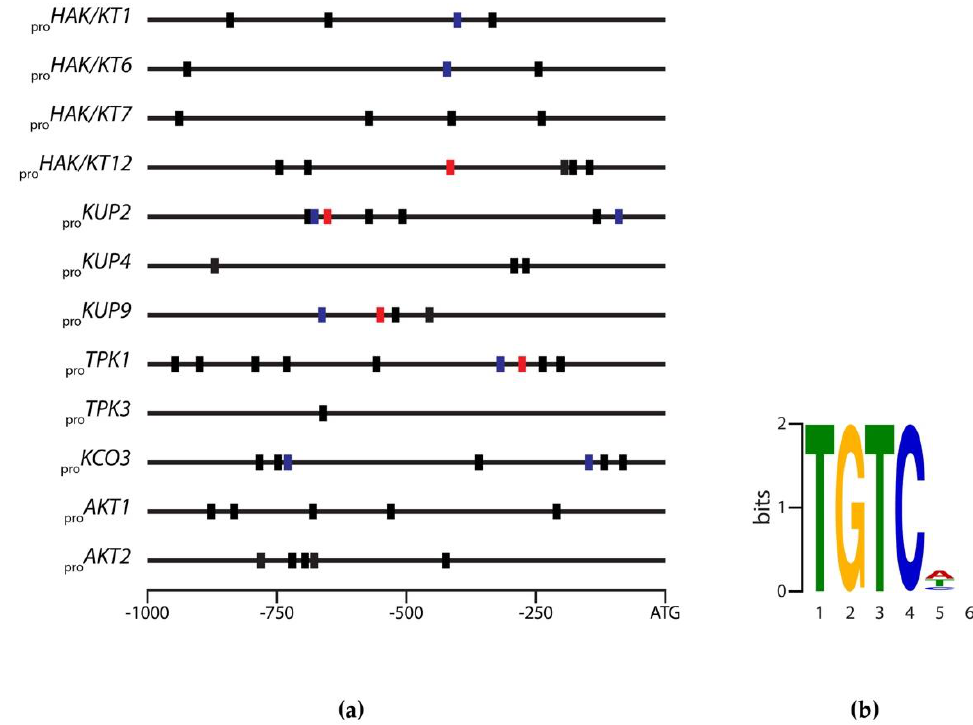
Figure 3. Identification of conserved auxin response factor (ARF) core-binding motifs in target promoters. ( a ) Representation of the 1,000 bp promoter fragments upstream of the ATG start codon. Red boxes represent the most frequent TGTCTC consensus sequence, while blue boxes show TGTCGN sequences and black boxes the TGTCNN core sequence motif; ( b ) Position weight matrix (PWM) representation of top-scoring 5-mers for the indicated AuxRE consensus sequence motifs.